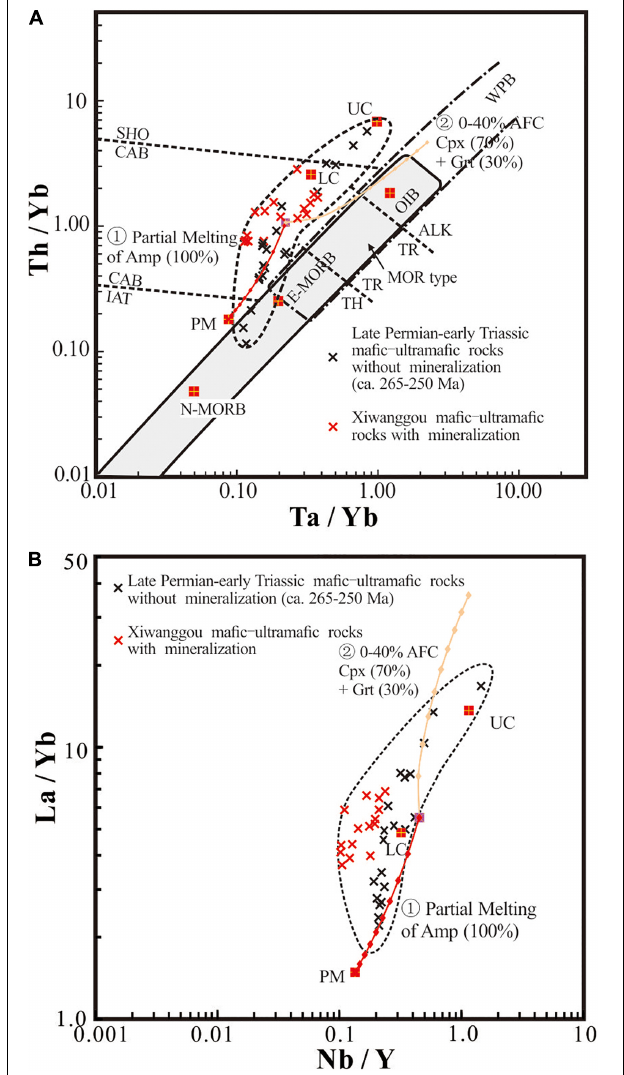
FIGURE 11 | Nb/Y vs. La/Yb (A) and Ta/Yb vs. Th/Yb (B) diagrams of the middle-late Permian mafic-ultramafic rocks from the East Kunlun Orogen. It plots in the field around primary mantle (PM), lower crust (LC) and upper crust (UC) composition points. AFC, assimilation and fractional crystallization; Amp, amphibole; Bt, biotite; Cpx, clinopyroxene; Grt, garnet. The upper (UC) and lower crustal (LC) components are based on Taylor and Mclennan (1995). The partial melting starting material was an average composition of primary mantle based on Sun and McDonough (1989). The partitioning coefficients for different mafic–ultramafic rock-forming minerals from Keskin (1994) are used in the melting and crystallization fractionation model. Tick marks explain the fraction of partial melting versus various minerals calculated using the petromodeler software (Ersoy, 2013). The data of the Xiwanggou fertile rocks are from this study and Kong et al. (2019b), and those of the barren rocks are from Jiadang (Xiong et al., 2011a; Kong et al., 2018), Bairiqili (Xiong et al., 2011b), and Langmuri (in published)